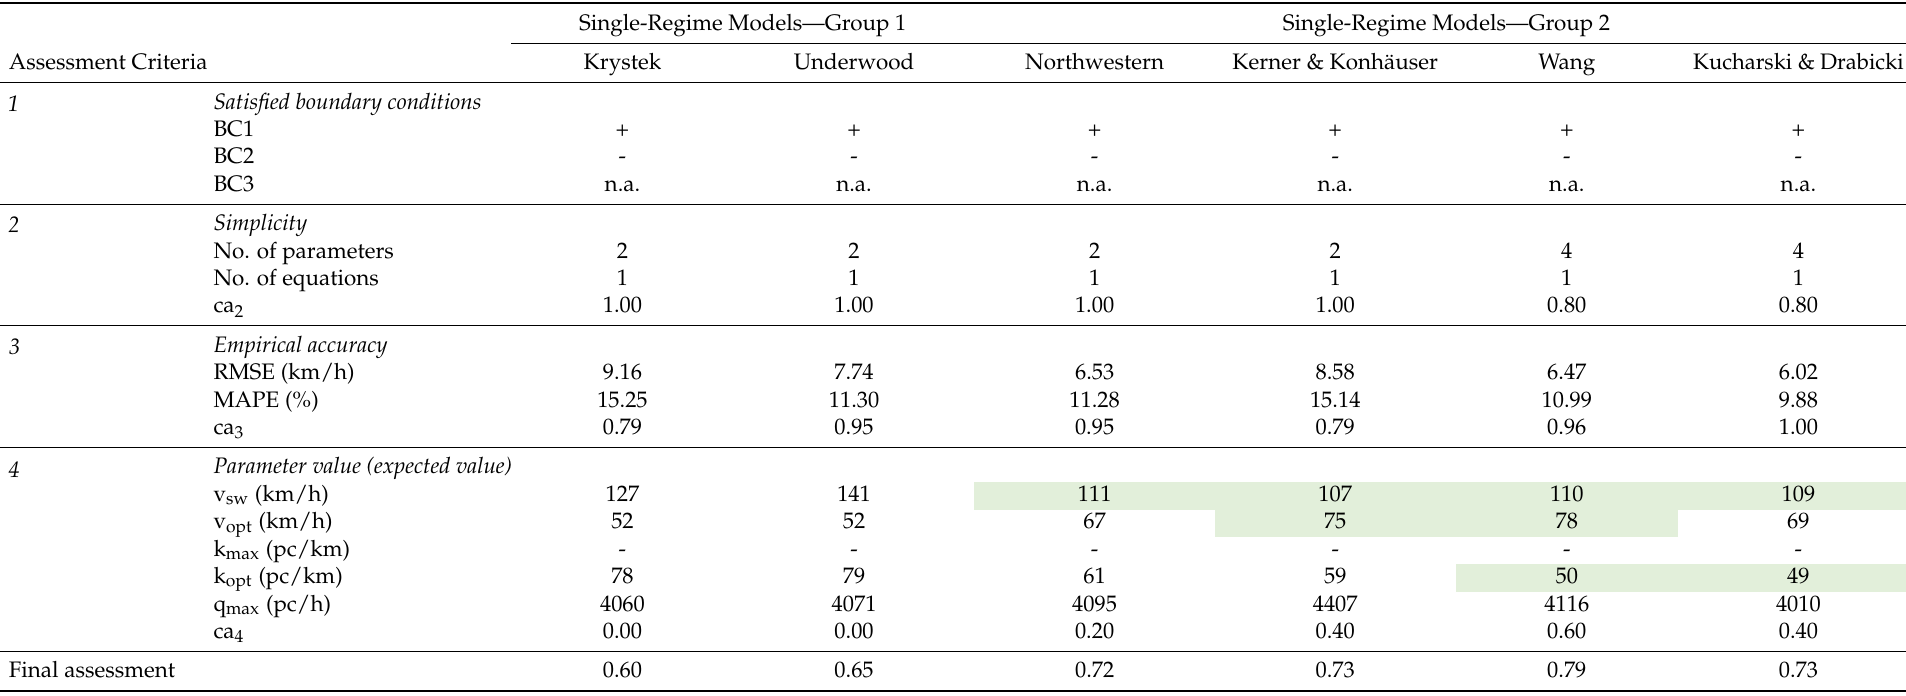
Table 6. Assessment and comparison of traffic flow models (unsatisfied